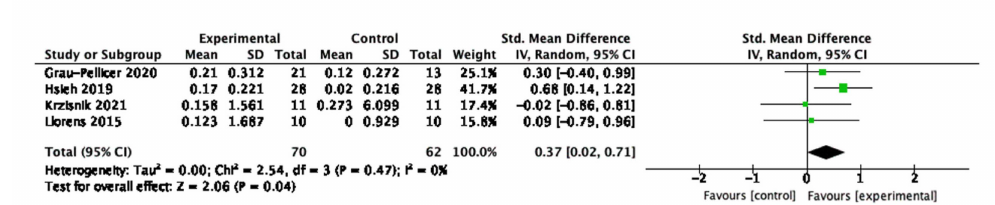
Figure 7. Subgroup analysis for the 10 m walk test.